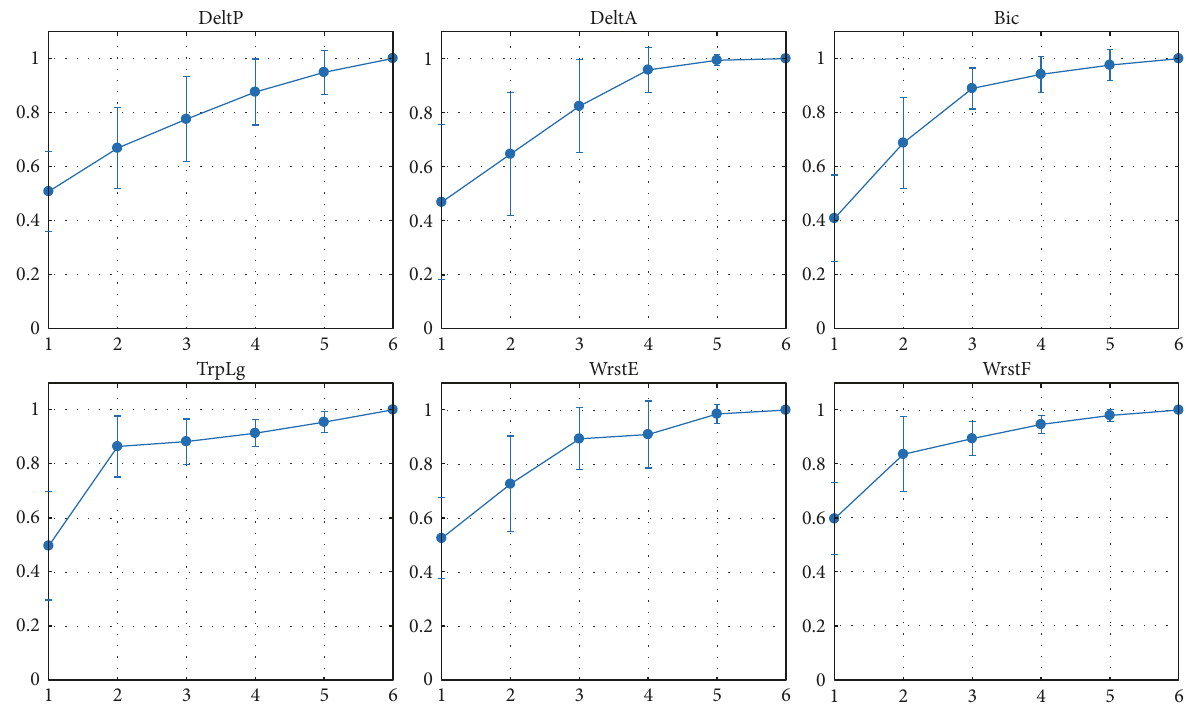
Figure 21: Activation reconstruction quality per muscle. Results per muscle show discrepancies in the reproducibility of the results. Some muscles have relatively consistent patterns to reconstruct with 2 synergies (triceps long, wrist fl exor group) whereas some other may be better reconstructed thanks to higher synergy levels